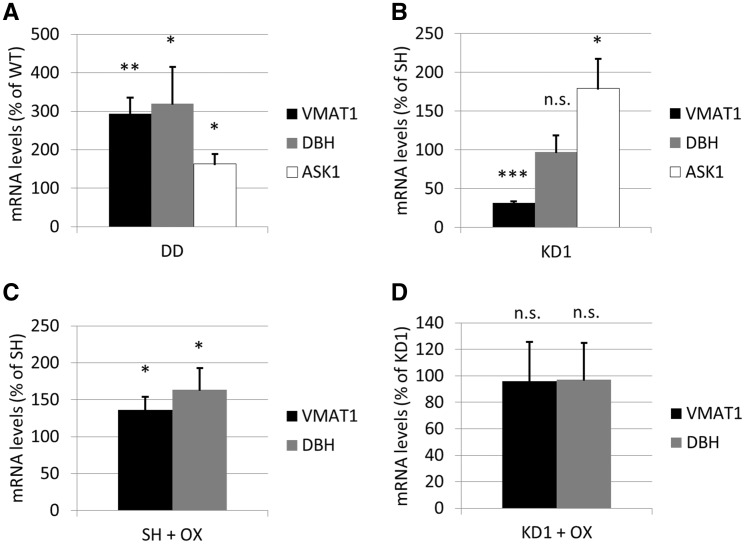
VMAT1, DBH and ASK1 mRNA in oxidized and DJ-1 KD cells. qPCR was performed on SH-SY5Y cells, KD1, WT and DD cells and relative expression calculated. Data were normalized to β-actin mRNA levels. (A) mRNA levels in DD cells are expressed as % WT levels (n = 4–5). (B) KD1 mRNA levels are expressed as % SH-SY5Y cells (n = 4–5). (C) SH-SY5Y cells treated with oxidative stress (1 mM BSO for 24 h and 1 mM H2O2 for 30 min; OX) and expressed as % of untreated SH-SY5Y (n = 3–5). (D) mRNA levels in KD1 cells treated with oxidative stress and expressed as % untreated KD1 cells (n = 3–5). Statistical significance calculated using Students T-test versus respective control. *P < 0.05 vs. SH/WT; **P < 0.01 vs. WT; ***P < 0.001 vs. SH; n.s., non-significant.